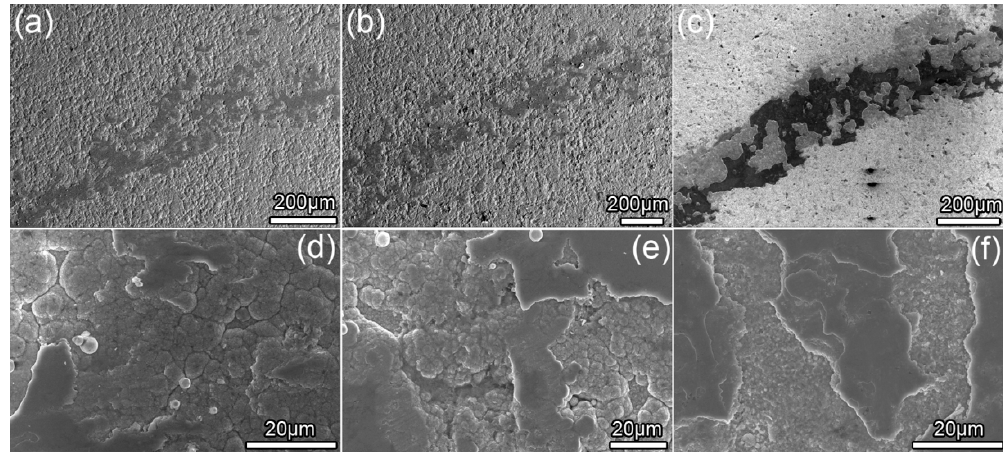
Figure 7. Wear morphology of various samples: ( a , d ) as-plated; ( b , e ) A500; ( c , f ) A1100.